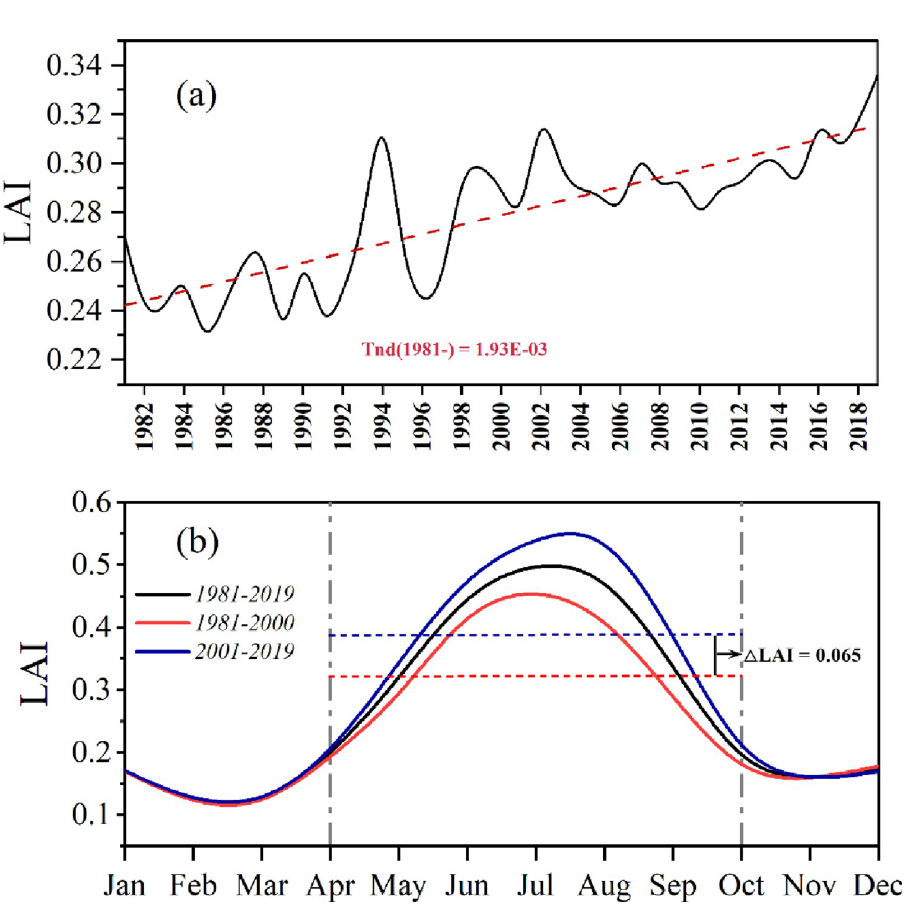
Fig 9. Average April-October LAI for each year from 1981-to 2019 for the entire ELB (a) and average monthly LAI for three different periods (b). The red dotted line shows the linear fit for 1981–2019, and "Tend (1981-)" denotes the trend for 19881–2019, p < 0.05.